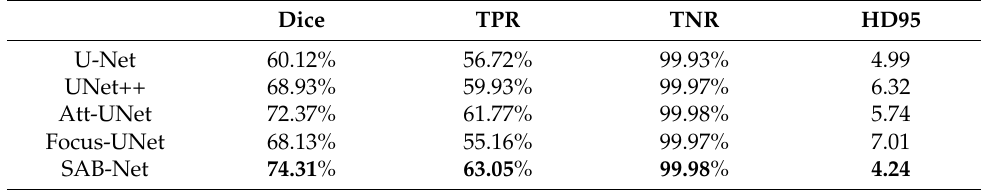
Table 6. Segmentation results obtained on the Spleen CT dataset.